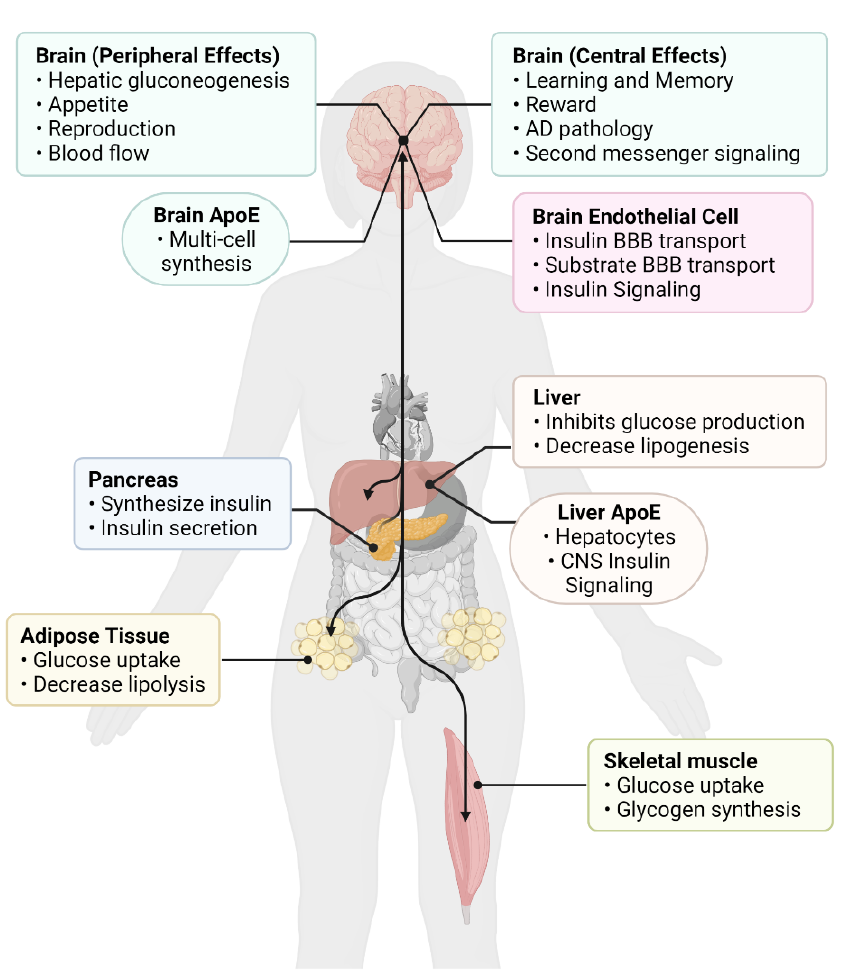
Figure 1. Overview of peripheral and central insulin actions. Insulin action primarily originates from the pancreas, the site of insulin production, and can act on many target tissues (black arrows). In the periphery, insulin has actions in all tissues, but predominantly affects major metabolic tissues, such as the adipose tissue, liver, and skeletal muscle. Insulin crosses the blood – brain barrier (BBB) to act within the central nervous system (CNS) to regulate both direct effects within the brain as well as elicit indirect signaling events back to the periphery. Insulin can also signal at the brain endothelial cell to regulate BBB function. On the other hand, apolipoprotein E (apoE) has distinct pools (peripheral and central), as apoE does not cross the BBB, with liver and brain producing the majority of these apoE pools. There is still crosstalk between these two pools as peripheral apoE can still readily affect central apoE, and vice versa, through indirect actions (i.e., via the gut microbiome and gut-liver-brain axis). Created with Biorender.com software.